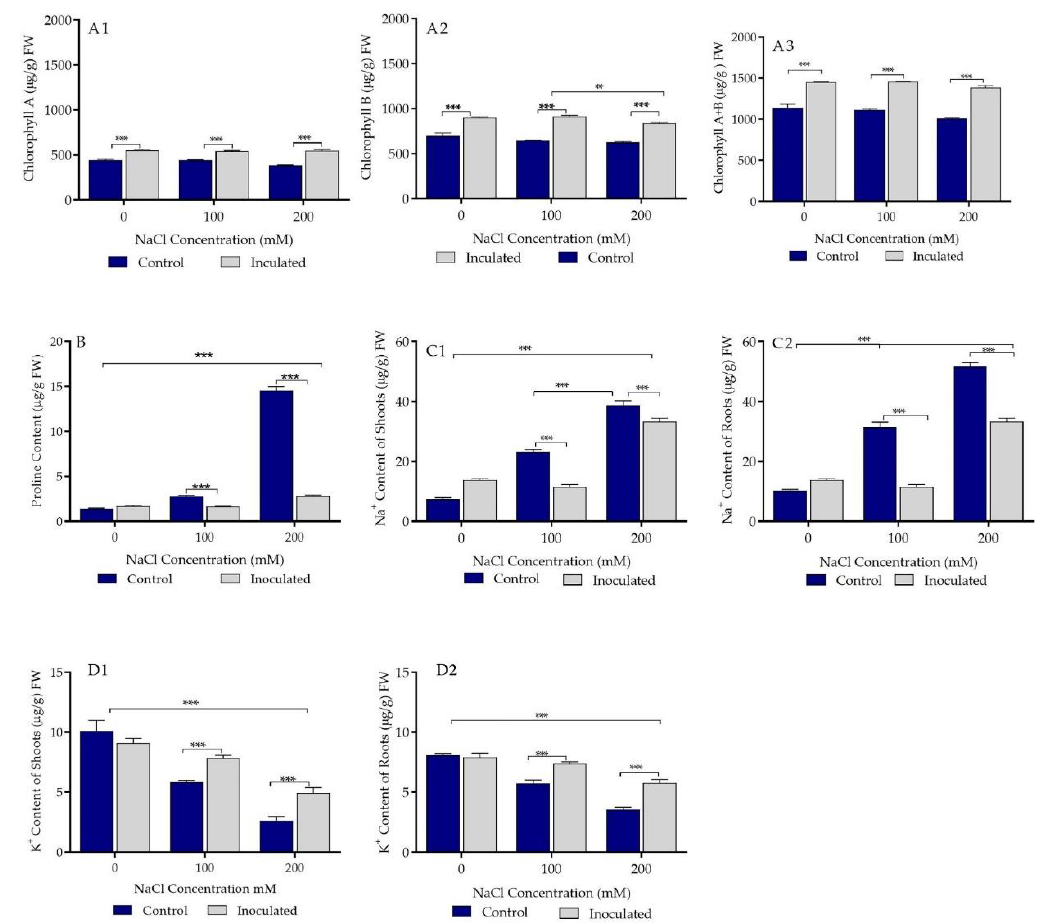
Figure 4. E ff ect of plant growth-promoting rhizobacteria (PGPR) P. agglomerans strain Pa inoculation on biochemical parameters of durum wheat cv Waha plants grown under saline and non-saline conditions in sand pots. ( A1 , A2 , A3 ) E ff ect of bacterial inoculation (isolate Pa) on chlorophyll a, b, and a + b chlorophyll content ( µ g / g FW) in the presence of three concentrations (0, 100, and 200 mM) of NaCl. ( B ) E ff ect of bacterial inoculation (isolate Pa) on proline content ( µ g / g FW) under the presence of three concentrations (0, 100, and 200 mM) of NaCl. ( C1 , C2 ) E ff ect of bacterial inoculation (isolate Pa) on shoot and root Na + content ( µ g / g FW). ( D1 , D2 ) E ff ect of bacterial inoculation (isolate Pa) on shoot and root K + content ( µ g / g FW). The bar plots represent the mean ± standard error of three di ff erent experiments. GraphPad Prism 8 was used to perform statistical analysis, with a two-way ANOVA and Tukey’s multiple comparison post-test. Only significant variations are displayed ** p < 0.01, *** p < 0.001.